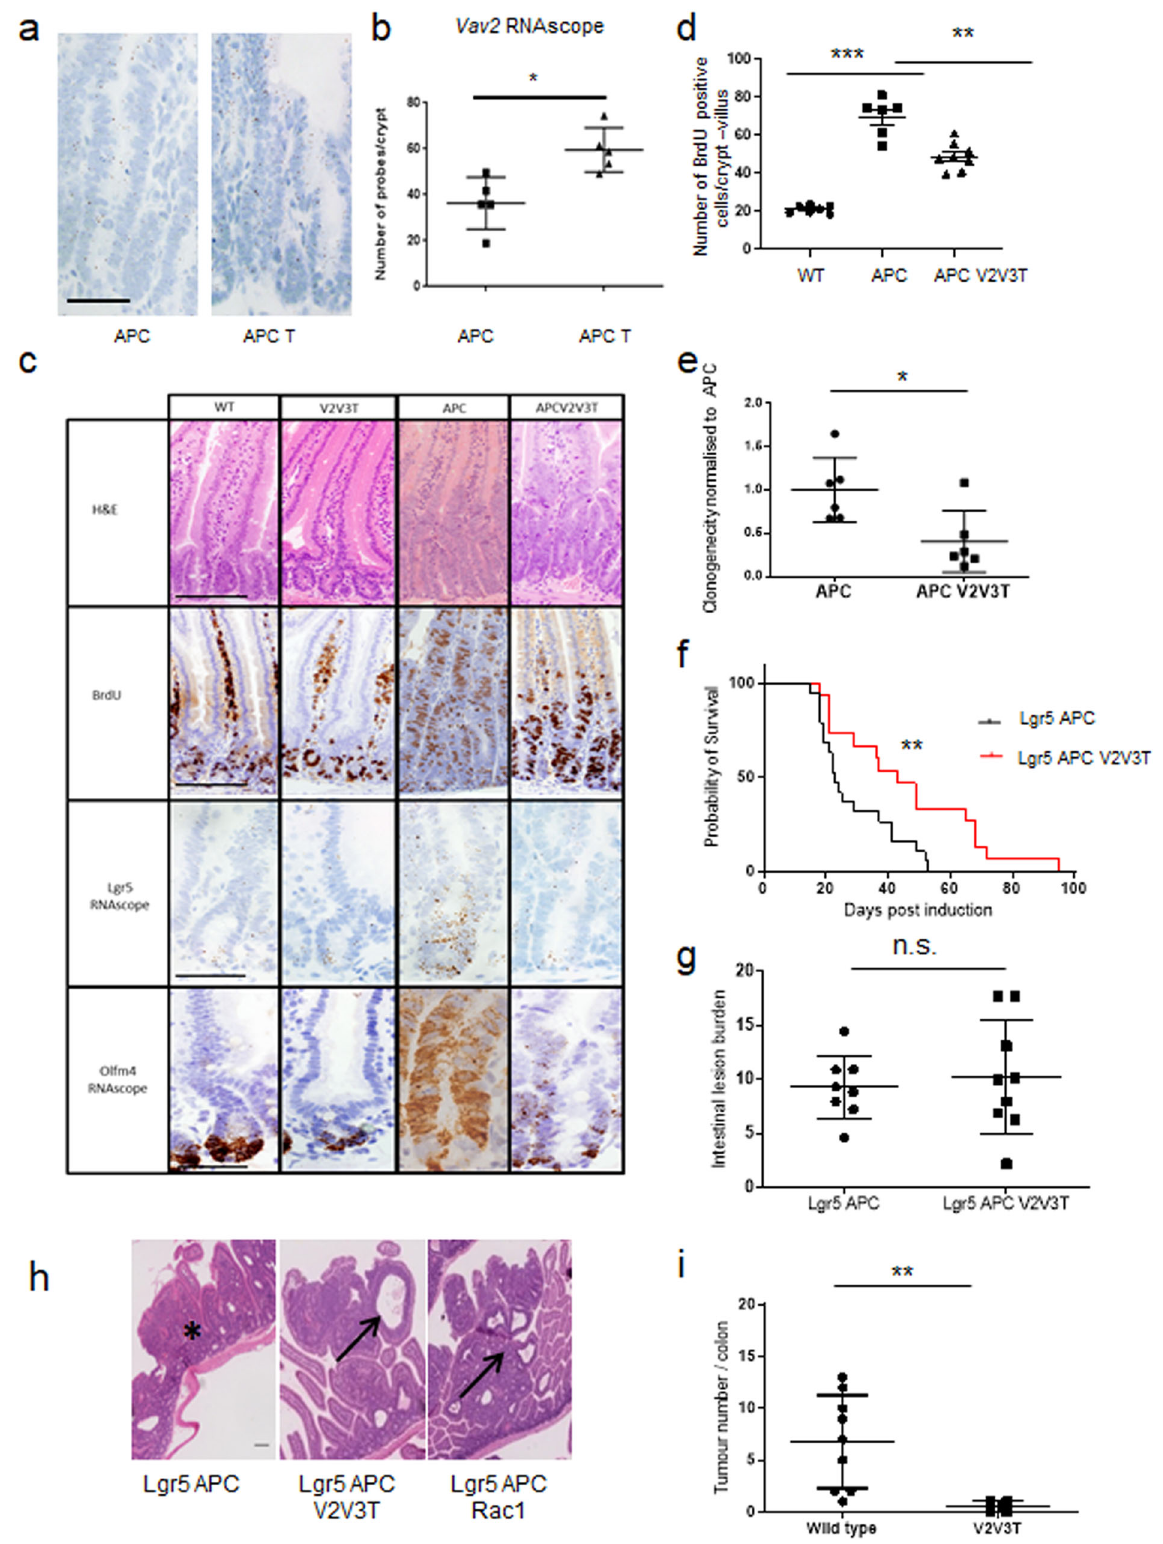
The role of VAV2, VAV3 and TIAM1 on WNT-driven pro- cesses is intestine-speci fi c . One important question that remained was how speci fi c this transcriptional network of GEF expression resulting from WNT activation was to intestinal dis- ease. As mentioned previously, triple knockouts are viable and fertile with normal intestinal homeostasis, suggesting little impact